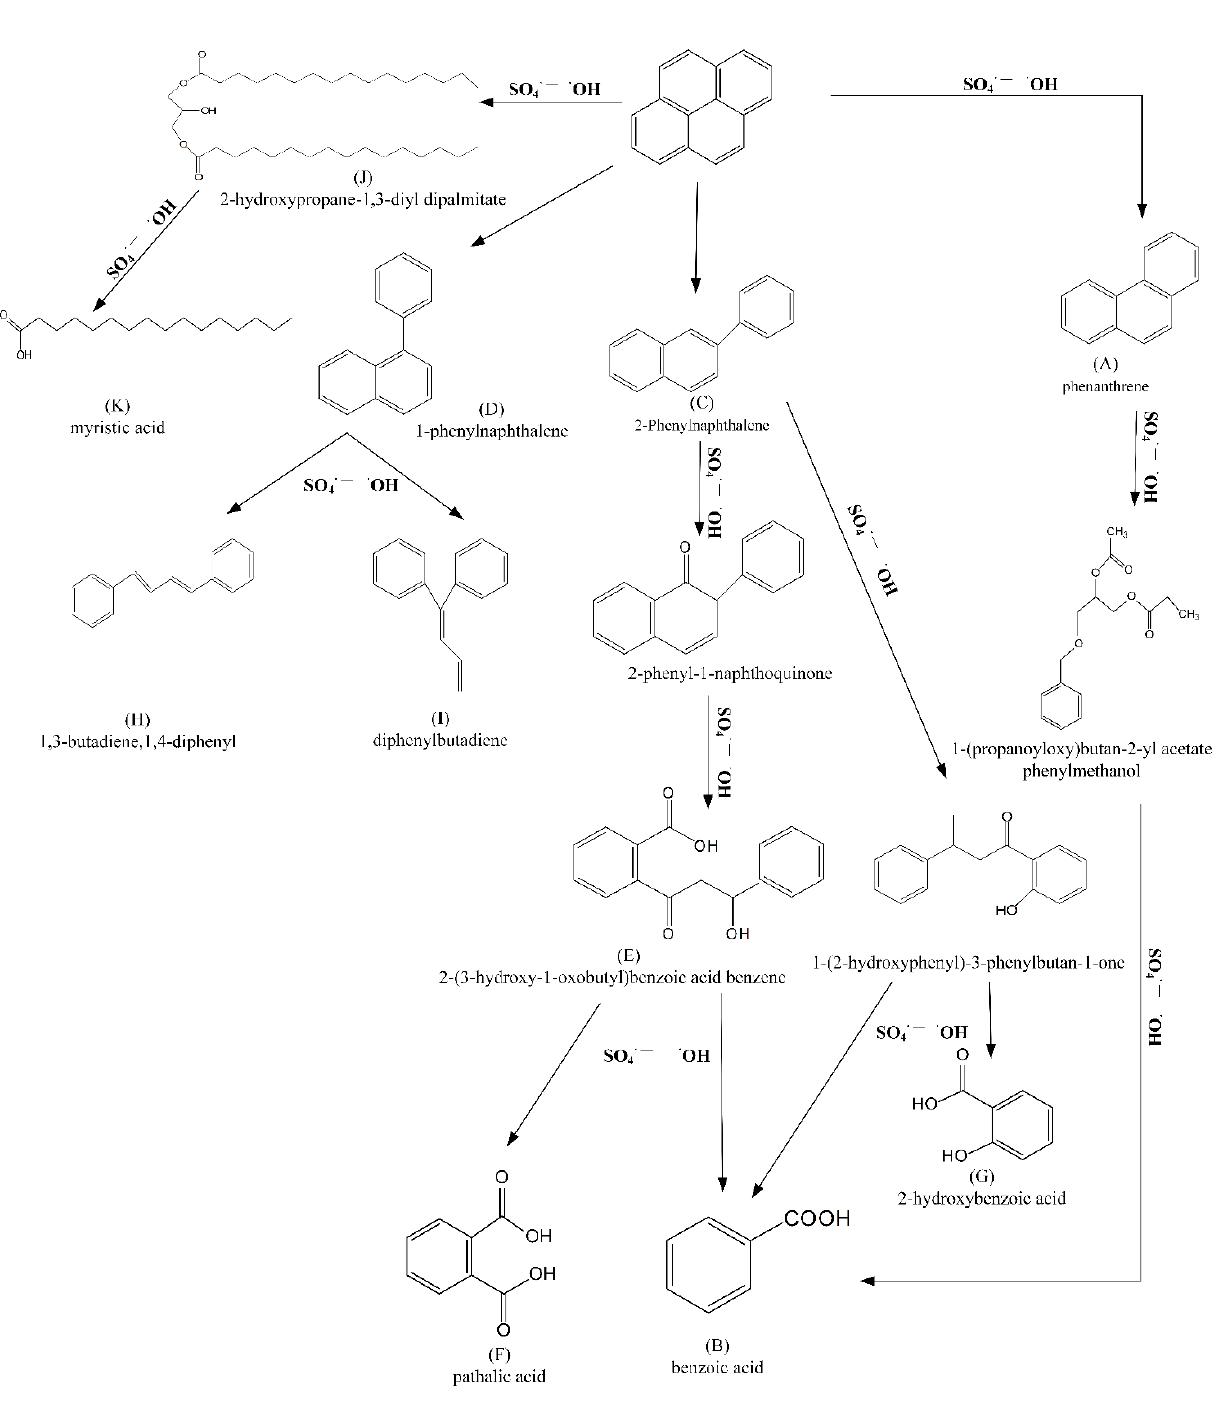
Figure 8. Degradation pathways of pyrene in persulfate oxidation systems.